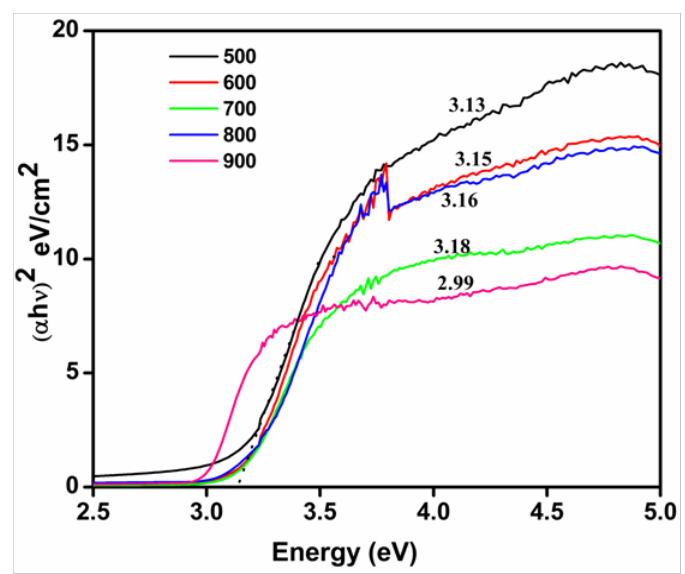
Figure 10. UV-Tauc plot of TiO 2 nanoparticles calcined at different temperatures.